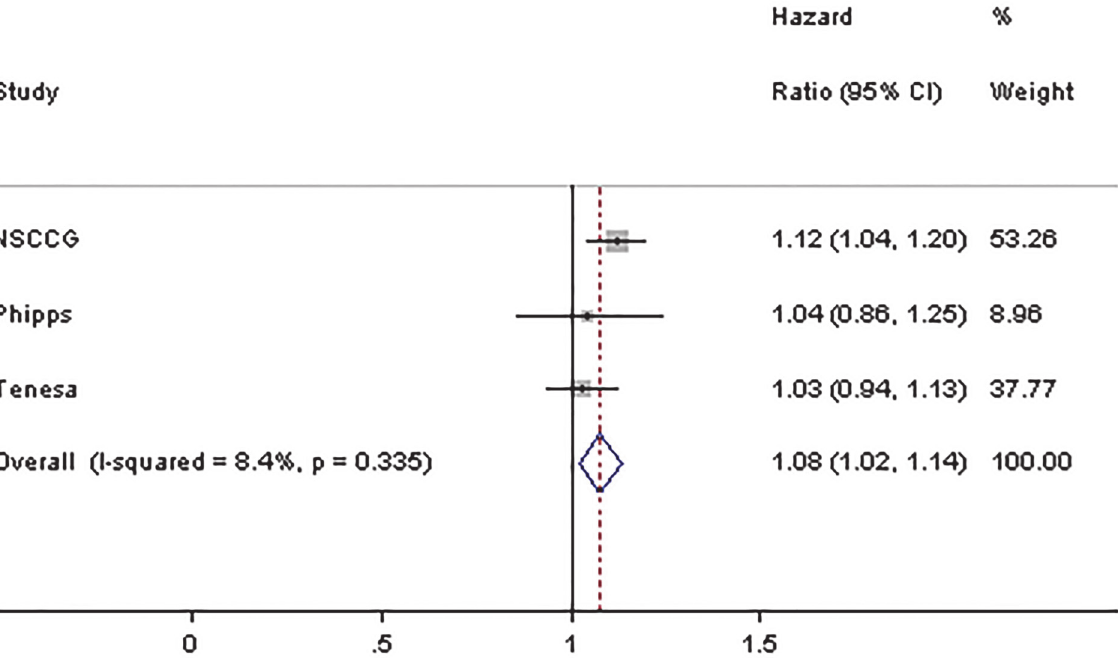
Fig 3. Forest plot showing the results of a meta-analysis combining HR for the SNP rs4444235. Horizontal lines represent 95% confidence intervals. Each box represents the OR point estimate and its area is proportional to the weight of the study. The diamond (and unbroken line) denotes the overall summary estimate, with CIs given by its width. The unbroken vertical line is at the null value (OR = 1.0).